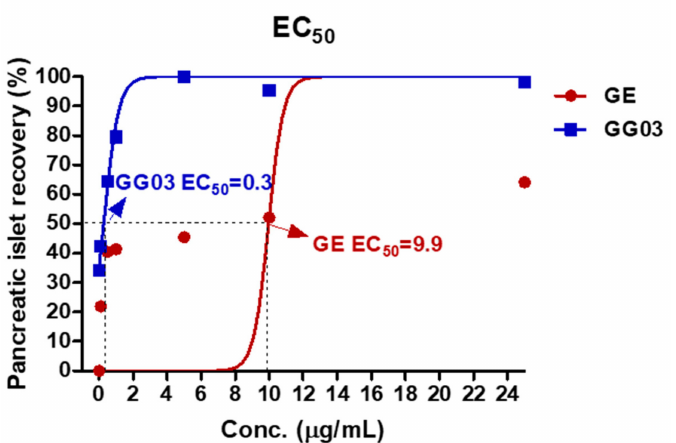
Figure 2. Dose-e ff ect curves of GE and GG03. The EC 50 of GE was 9.9 µ g / mL. The EC 50 of GG03 was 0.3 µ g / mL.